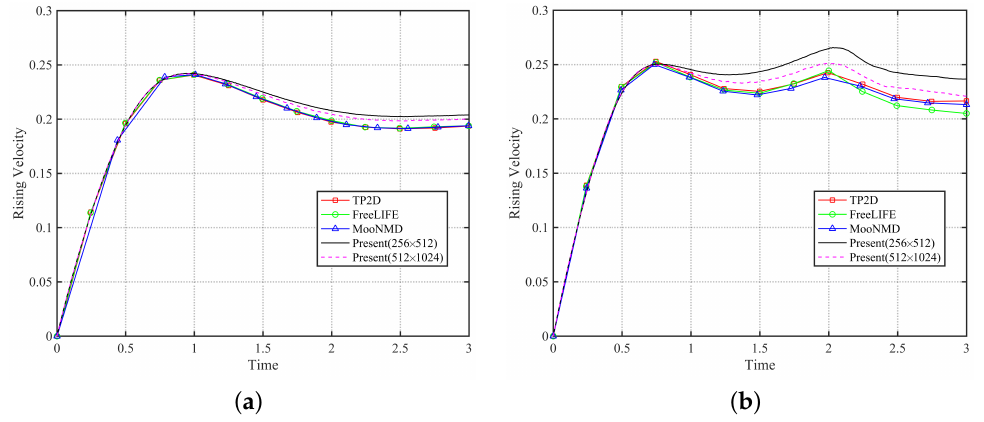
Figure 13. The evolution of the rising velocity of the bubble compared with the reference results presented by Hysing et al. [49] for the two-dimensional rising bubble problem. The colors of the references indicate the results achieved with TP2D (solid red), FreeLIFE (solid green), and MooNMD (solid blue), as well as the 256 × 512 (solid black) and 512 × 1024 (dashed pink) grids. ( a ) Case A. ( b ) Case